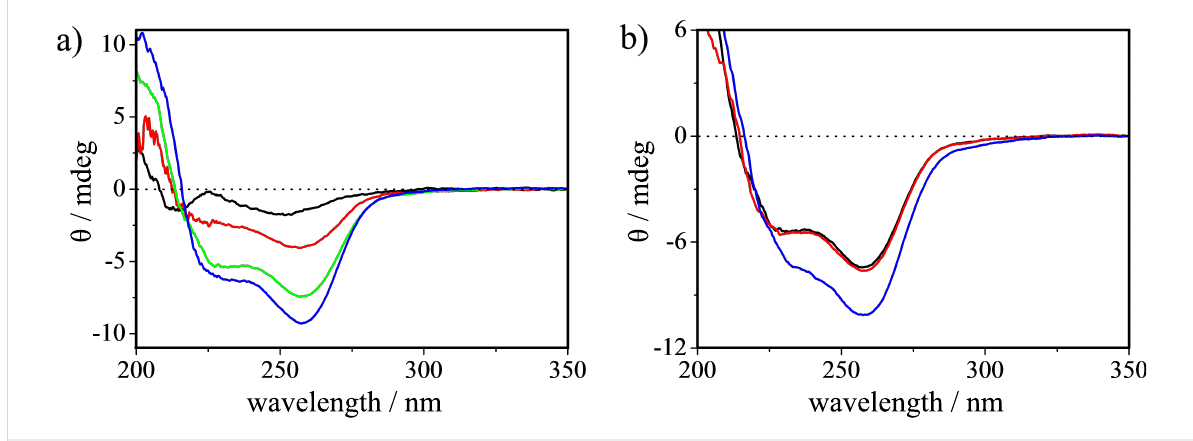
amount of PDA used in the preparation of CDNSs, it is likely that some of the carboxyl groups in PDA are not incorporated in the polymer chain, and hence, the solution pH may change the ionic state of the remaining carboxyl groups, affecting the sensi-